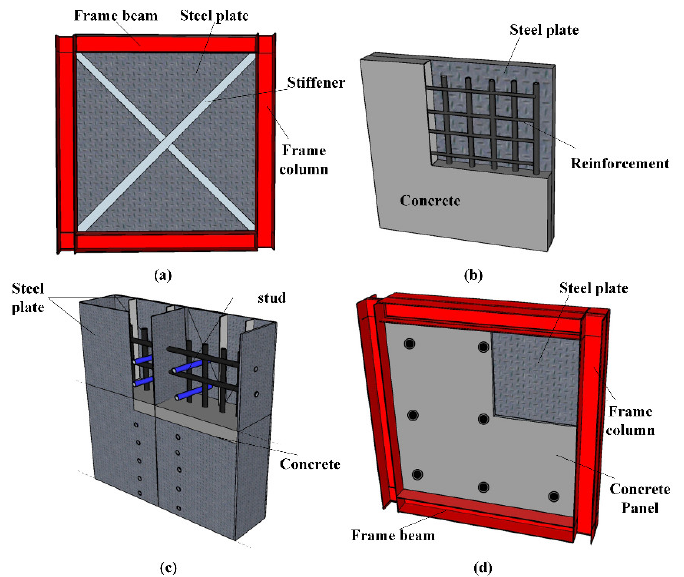
Figure 1. Different types of steel plate shear walls: ( a ) SPSW with stiffener; ( b ) steel plate embedded in concrete; ( c ) concrete wall confined by external steel plates; ( d ) PCSW.